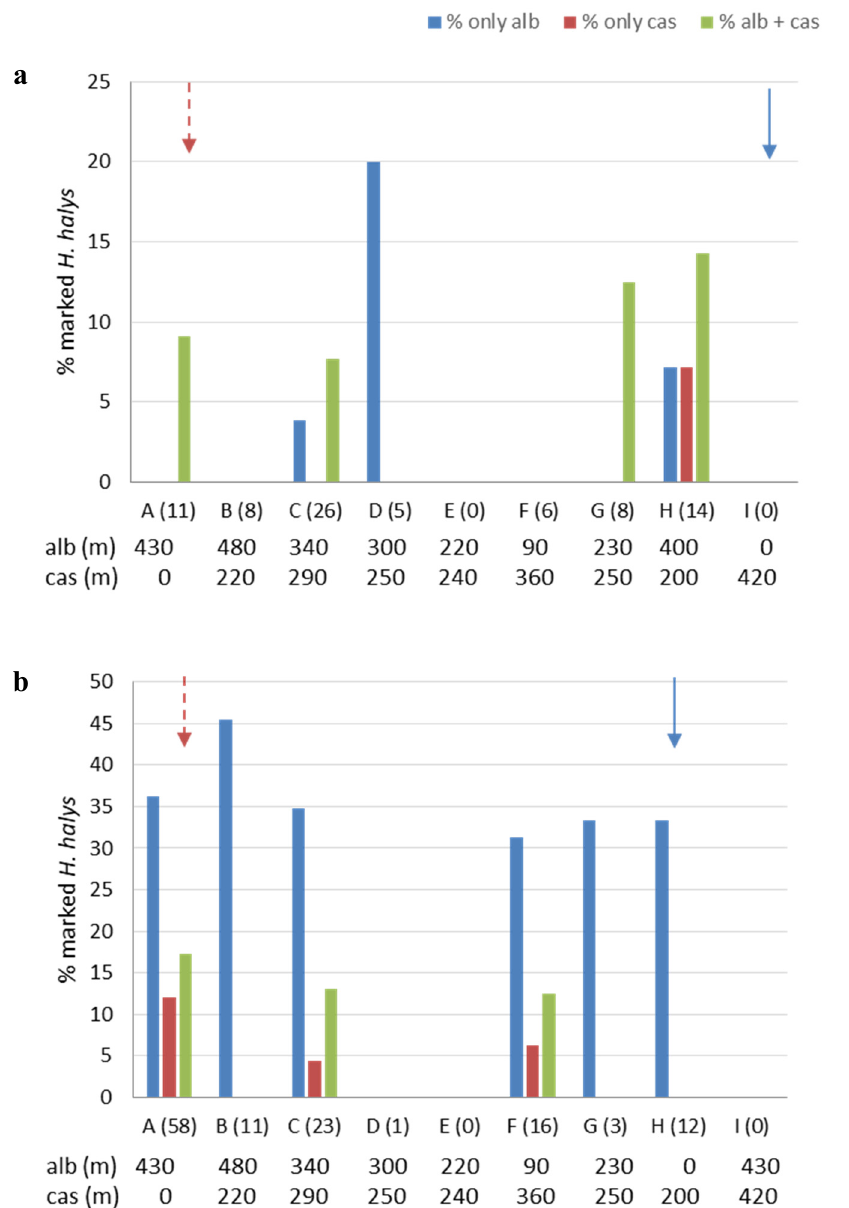
Figure 5. Total percentages of marked Halyomorpha halys adults collected in the sampling zones (A–H) of Area 1 from 17 April to 15 May ( a ) and from 16 May to 18 June ( b ). On the x-axes, for each zone, the total number of tested specimens is given in brackets. For each zone, the distance (meters) from the treatment site is also indicated either for albumin (“alb”) or casein (“cas”). Arrows designate the zones in which treatments with casein (dashed dark red arrow) and albumin (blue arrow) were applied.